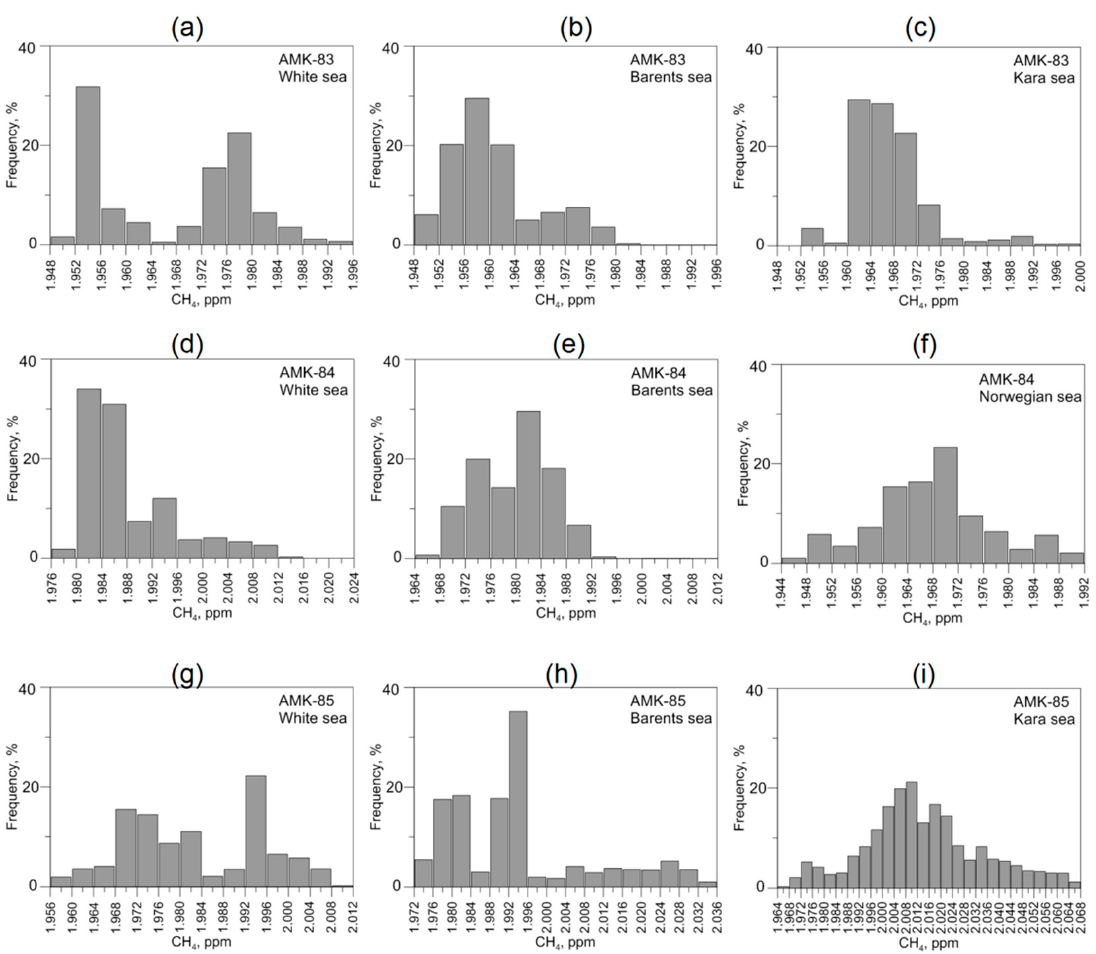
Figure 4. The frequency distribution of atmospheric CH 4 for different seas during АМК -83 (panels ( a – c )), АМК -84 (panels ( d – f )), and АМК -85 (panels ( g – i )) (1-minute averaging